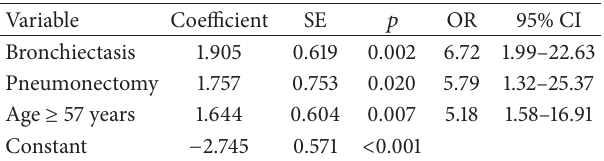
Table 3: Multivariate analysis of the three most important risk factors of effective use of ICU care after lung resection.